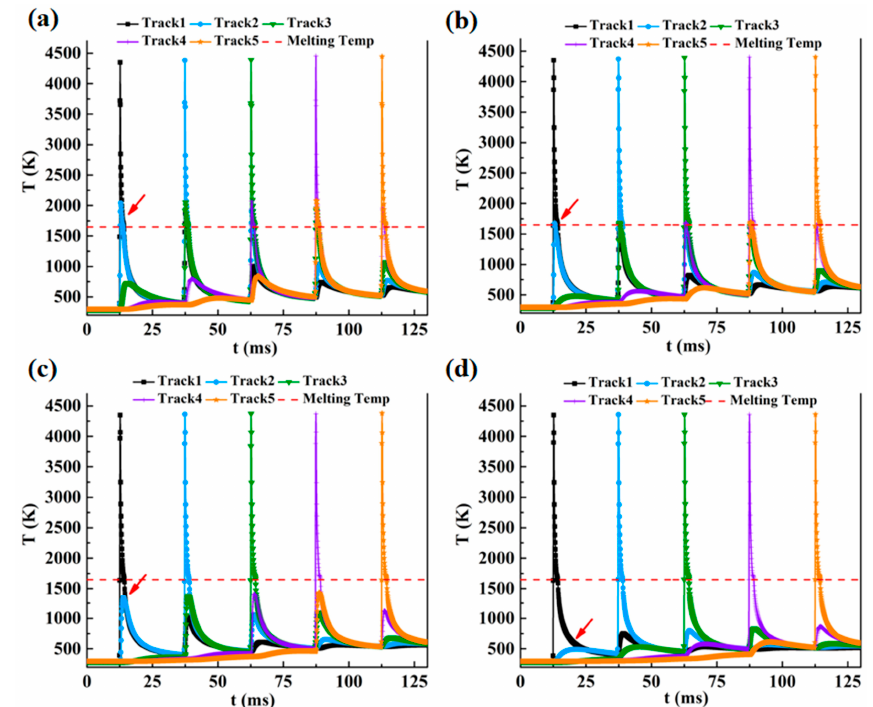
Figure 3. Cyclic melting and cooling of the scanning process of the five tracks for different hatch spacings: ( a ) 75 μ m, ( b ) 100 μ m, ( c ) 150 μ m, and ( d ) 200 μ m.